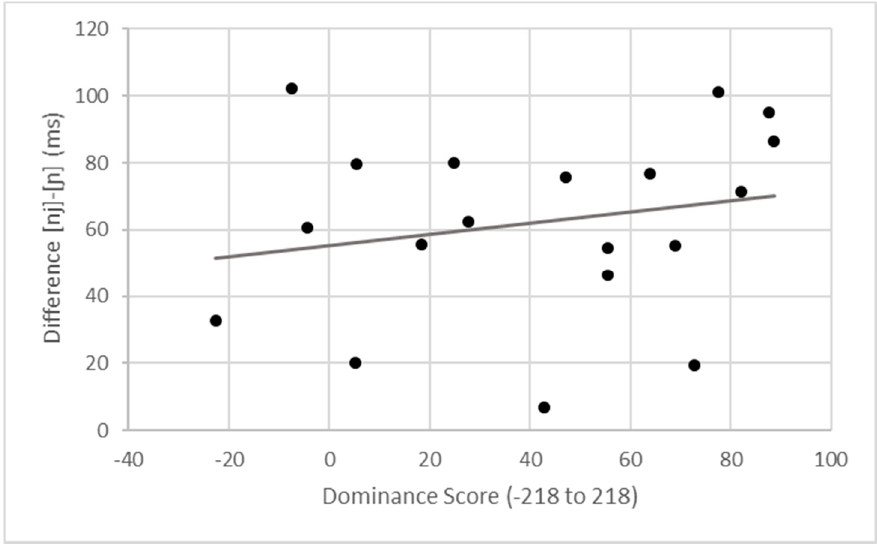
Figure 7. FV duration difference by language dominance score.